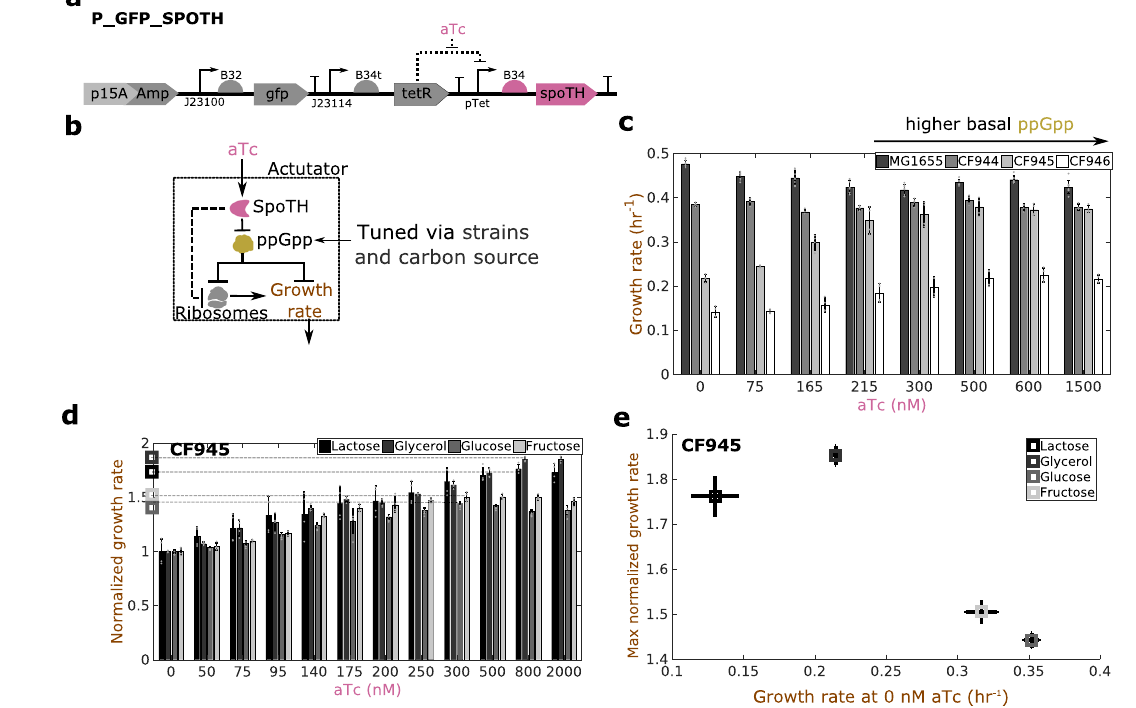
Fig. 2 | SpoTH gene activation increases growth rate. a P_GFP_SpoTH plasmid used to activate the SpoTH gene via the inducible pTet promoter. b Circuit describing how SpoTH induction via aTc affects ribosomes and growth rate. Addition of aTc increases SpoTH concentration, which lowers ppGpp concentra- tion and consequently upregulates both free ribosome concentration and growth rate 35 .Thedashed fl at headedarrow from SpoTHtoribosomesrepresentsthe load that SpoTH expression places on ribosomes as SpoTH ’ s mRNA is translated. c The growth rate as SpoTH is increased in the wild-type MG1655, CF944, CF945, and CF946 strains 35 growing in glycerol as the sole carbon source. d Growth rate nor- malized by the growth rate ataTc=0nM, asSpoTH is expressedinCF945growing